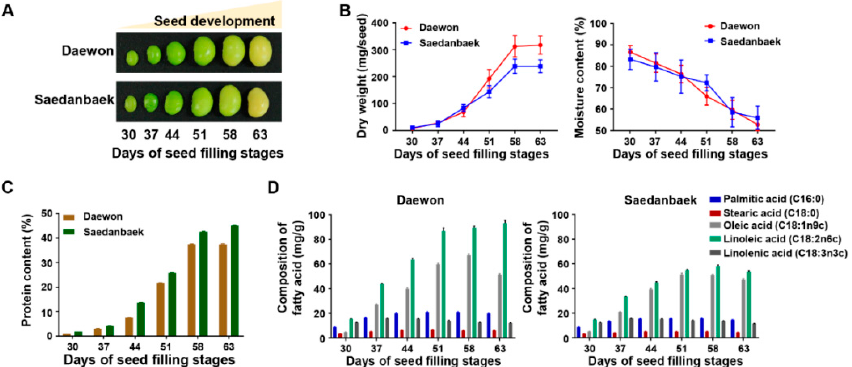
Figure 3. Physiological validation of filling stage samples. The morphological changes ( A ), dry weight, and moisture content ( B ) of Daewon and Saedanbaek varieties of soybean seeds during seed filling stages. A bar chart showing variations in the protein ( C ) and fatty acids contents ( D ) in Daewon and Saedanbaek varieties during seed filling stages.